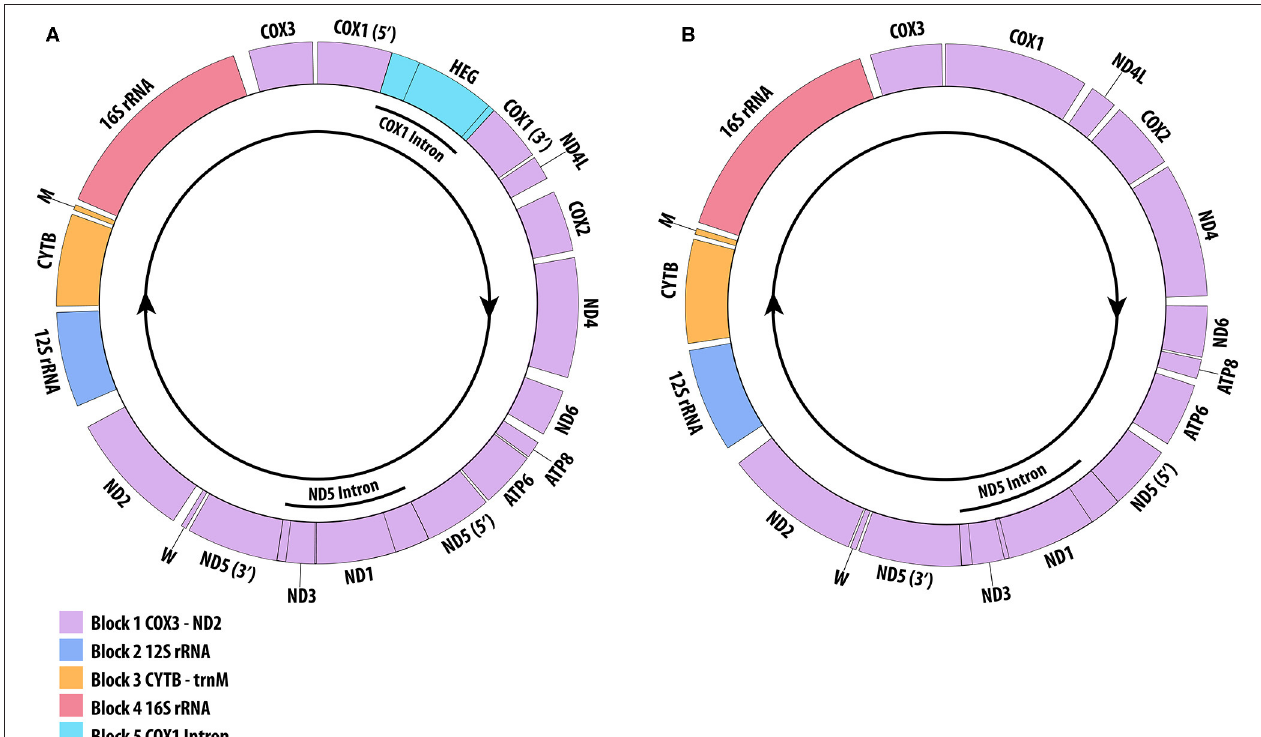
FIGURE 1 | Antipatharian mitogenome graphical map showing gene blocks and gene orders. tRNAs are displayed according to their one letter code. (A) Representative of families Antipathidae, Aphanipathidae, Leiopathidae, Myriopathidae and Stylopathidae with the COX1 intron (relative size based on Stichopathes abyssicola) . (B) Representative of families Cladopathidae and Schizopathidae with the absence of the COX1 intron (relative size based on Stauropathes cf . punctata). Arrow indicates direction of transcription. Gene map created using OGDraw (Greiner et al.,